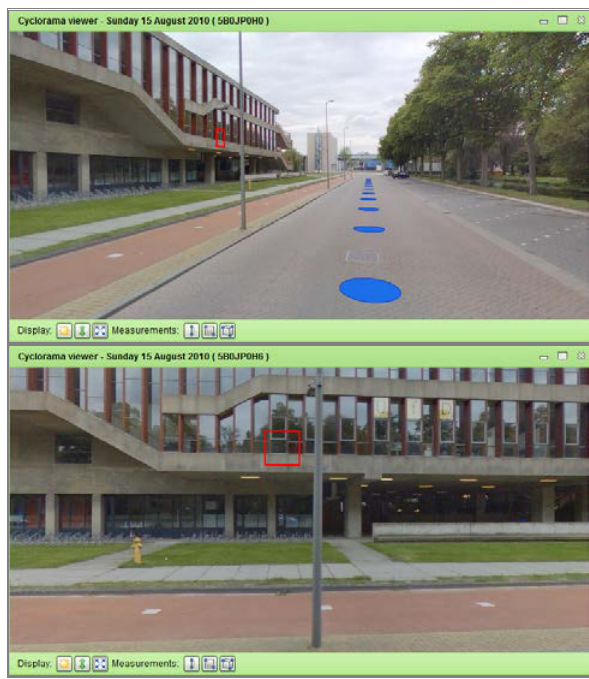
Figure 5. Navigation through Depth Cycloramas using depth data to identify a façade, represented by the rectangle cursor: a double click in the top window results in a jump to the picture shown in the bottom window.